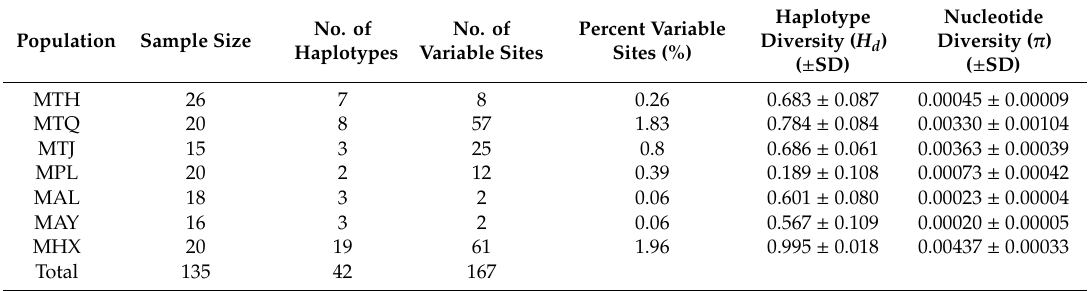
Table 1. Estimates of the molecular genetic diversity from combined mitochondrial DNA (mtDNA) sequences (3116 bp) of 7 populations in the genus Megalobrama .